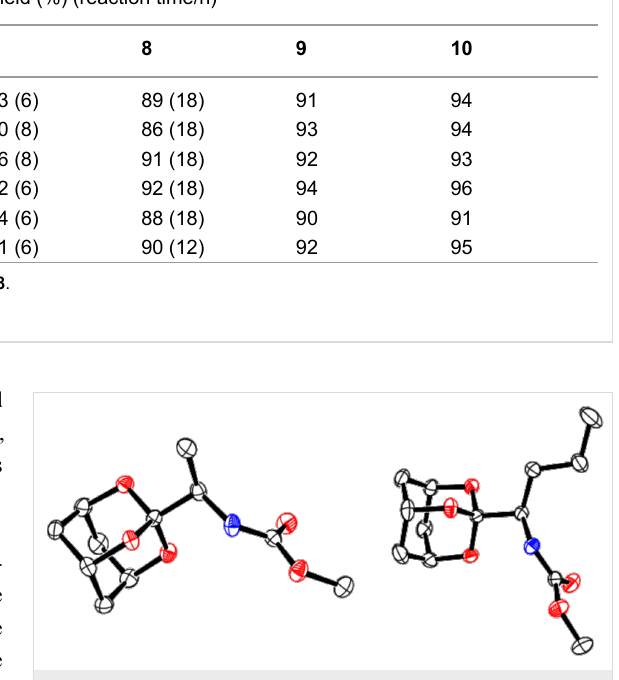
Figure 2: Crystallographic ORTEP diagrams at 30% ellipsoidal proba- bility of carbamates 10a (left) and 10b (right, Scheme 2, Table 3) [24].